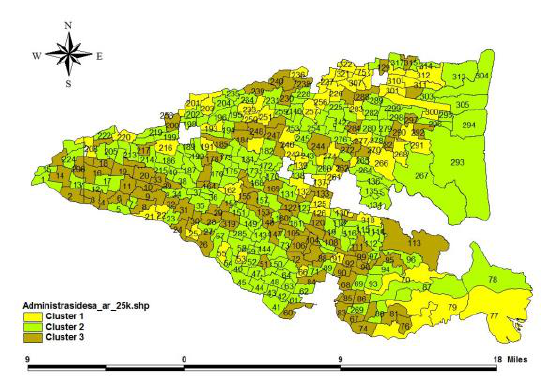
Figure 4: Village Grouping in Education Sector